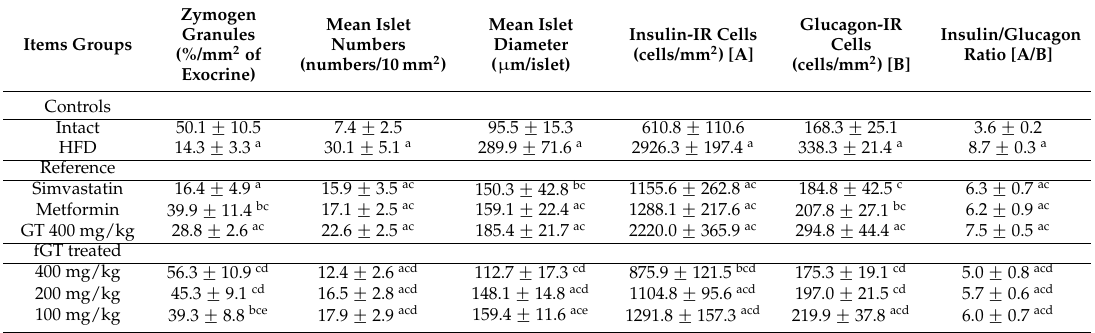
Table 5. Changes in histopathology-histomorphometry of the pancreas in NFD or HFD supplied mice.